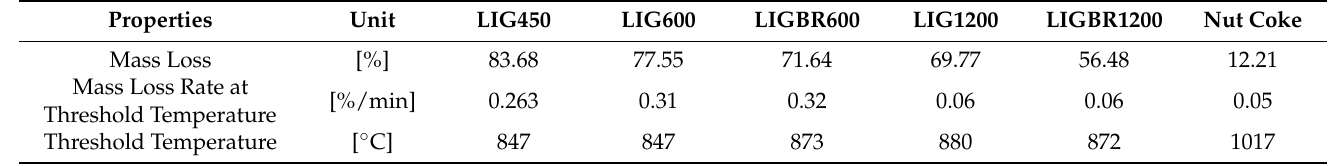
Table 4. Mass loss values for the samples and threshold temperatures for the gasification